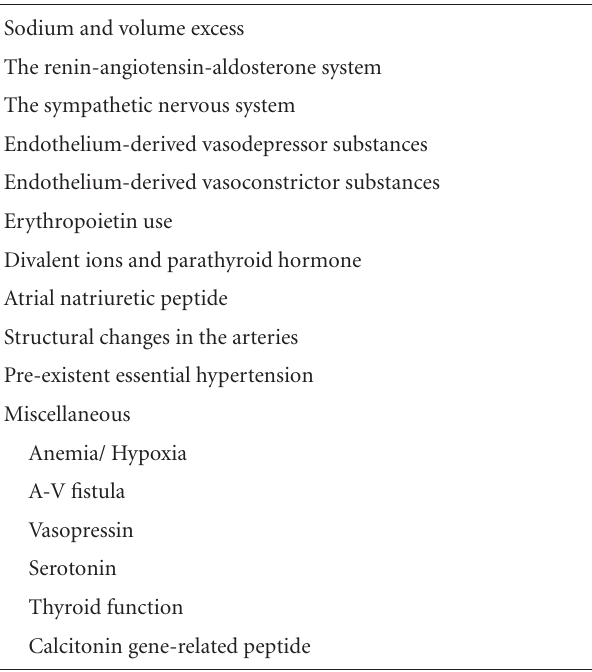
Table 1: Factors implicated in the pathogenesis of hypertension in end-stage renal